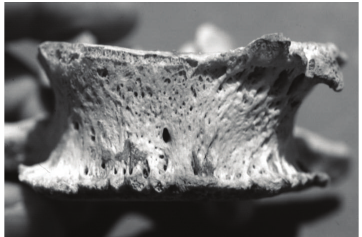
Figure 3: Macromorphology of nonsepcific pathological alteration of the ventral side of the vertebral body, which is still suggestive for a very early phase of osseous